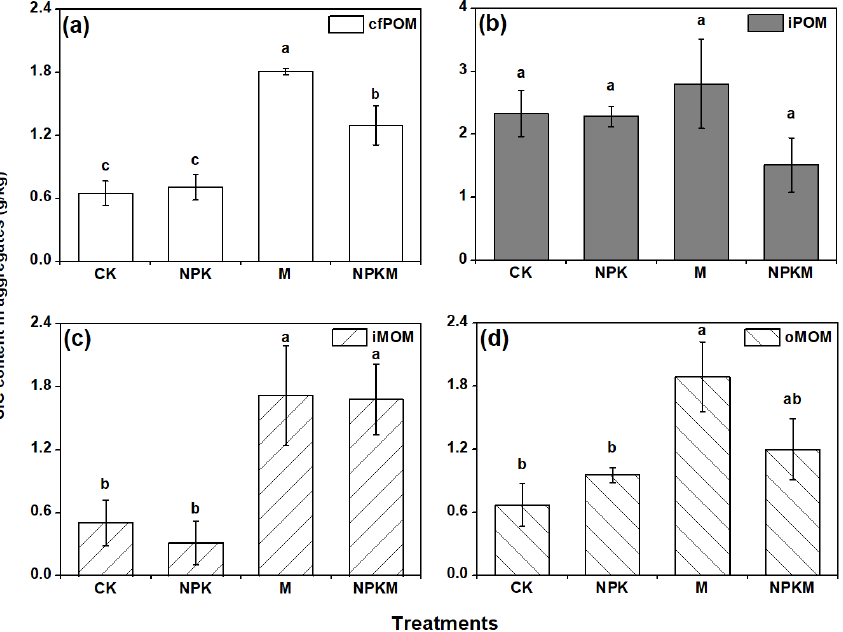
Figure 3. SIC content in different aggregates: ( a ) cfPOM; ( b ) iPOM; ( c ) iMOM; ( d ) oMOM. cfPOM means coarse free particulate organic matter fraction, iPOM means particulate organic matter inner microaggregate, iMOM means mineral-associated organic matter inner microaggregate, and oMOM means mineral-associated organic matter outer fraction. Error bars represent the standard deviations of the mean ( n = 3). Different characters above bars indicate significant differences among the treatments at p < 0.05.